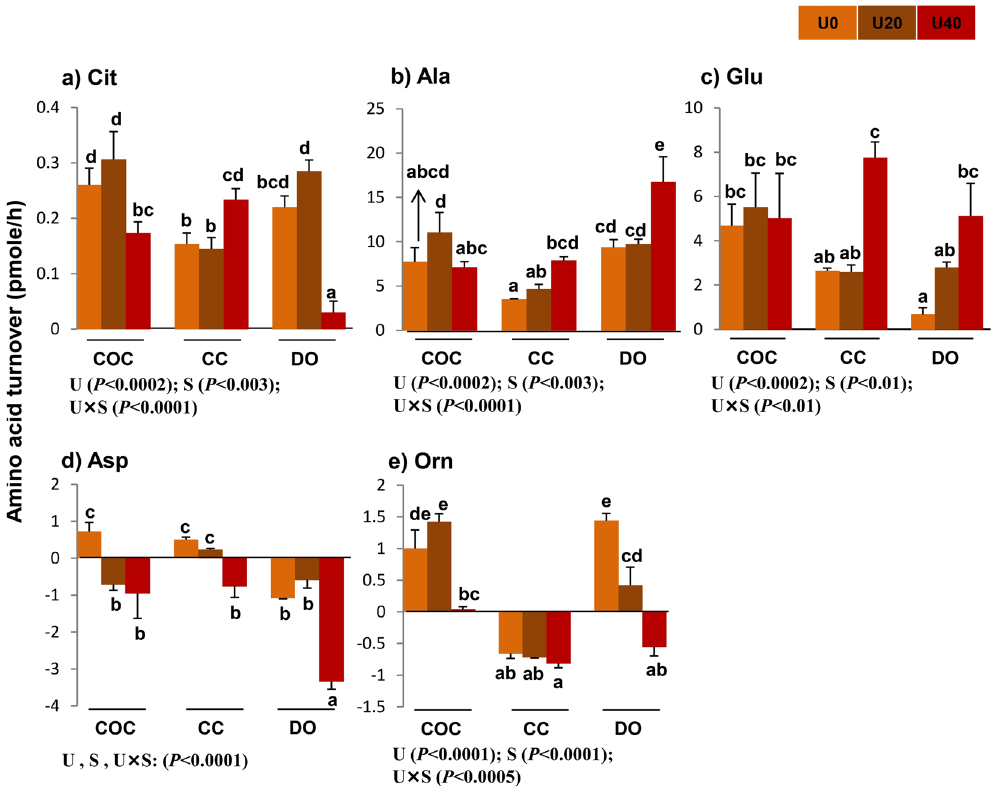
Figure 3. Effect of urea supplementation (0, 20, or 40 mg/dl) in maturation medium on the net depletion/ appearance of non-essential amino acids by bovine cumulus-oocyte complex, oocytectomized cumulus cells, or denuded oocytes after 24-h incubation. U0: control group (without urea); U20: 20 mg/dl urea; U40: 40 mg/ dl urea. COC: cumulus-oocyte complex; CC: cumulus cells; DO: denuded oocytes; U: the main effect of urea; S: the main effect of specimens (cell type: COCs, DOs, and CCs); U × S: interaction between urea and cell type. Data are presented as least squares means (LSM) ± standard error mean (SEM) indicated by two-way ANOVA over PROC GLM. Different letters (a, b, c, etc.) indicate significant differences between the treatments at P < 0.05. NS: